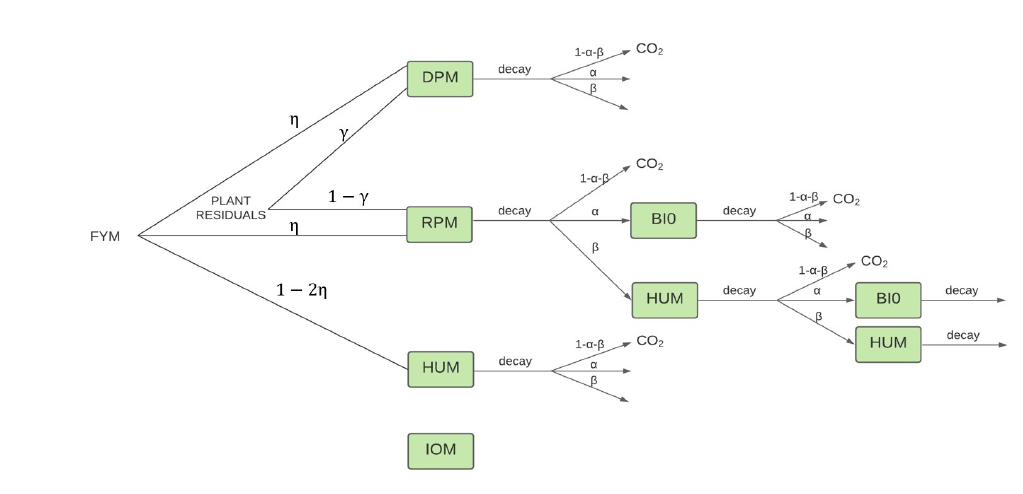
Figure 1. Flow diagram of the Rothamsted Carbon (RothC) model. FYM, Farmyard Manure; DPM, Decomposable Plant Material; RPM, Resistant Plant Material; BIO, microbial Biomass; HUM, Humified organic matter; IOM, Inert Organic